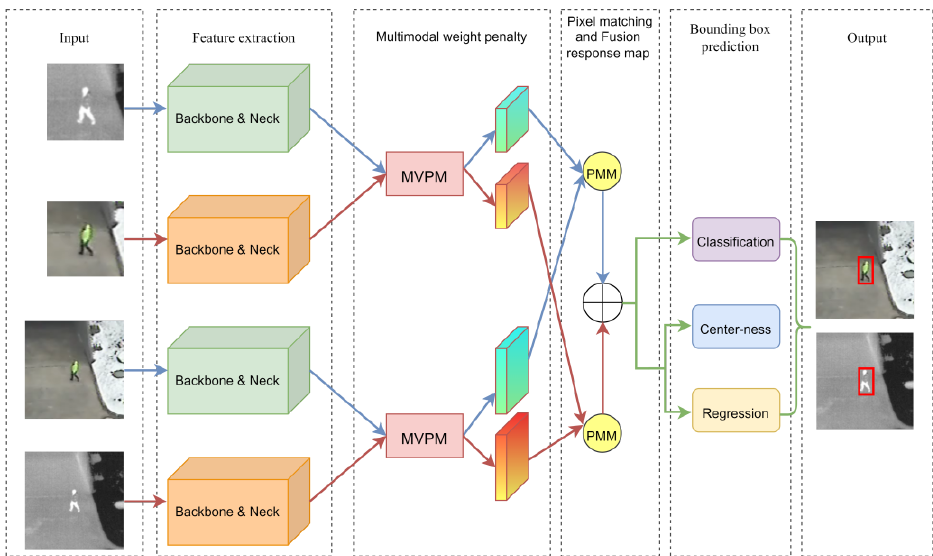
Figure 1. The overall architectural diagram of the proposed algorithm. The overall network consists of four main components: a double Siamese network for feature extraction, an MWPM for enhancing multi-modal features, a PMM for generating fusion response maps, and an anchor-free position prediction network for generating bounding boxes.